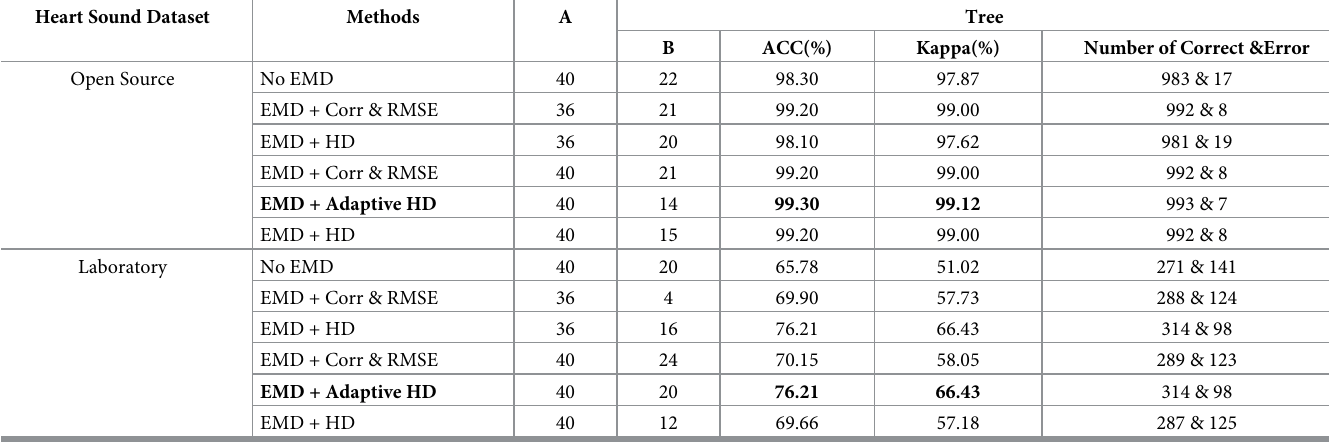
Table 8. Comparison of accuracy and feature dimension under different methods based on tree.